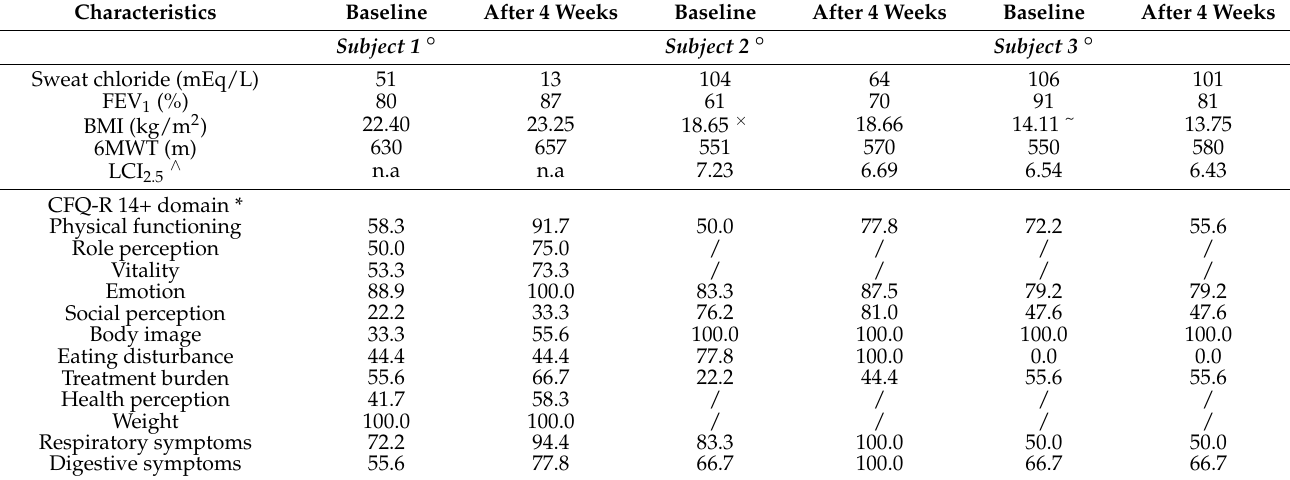
Table 1. Comparison of change in all variables over the treatment